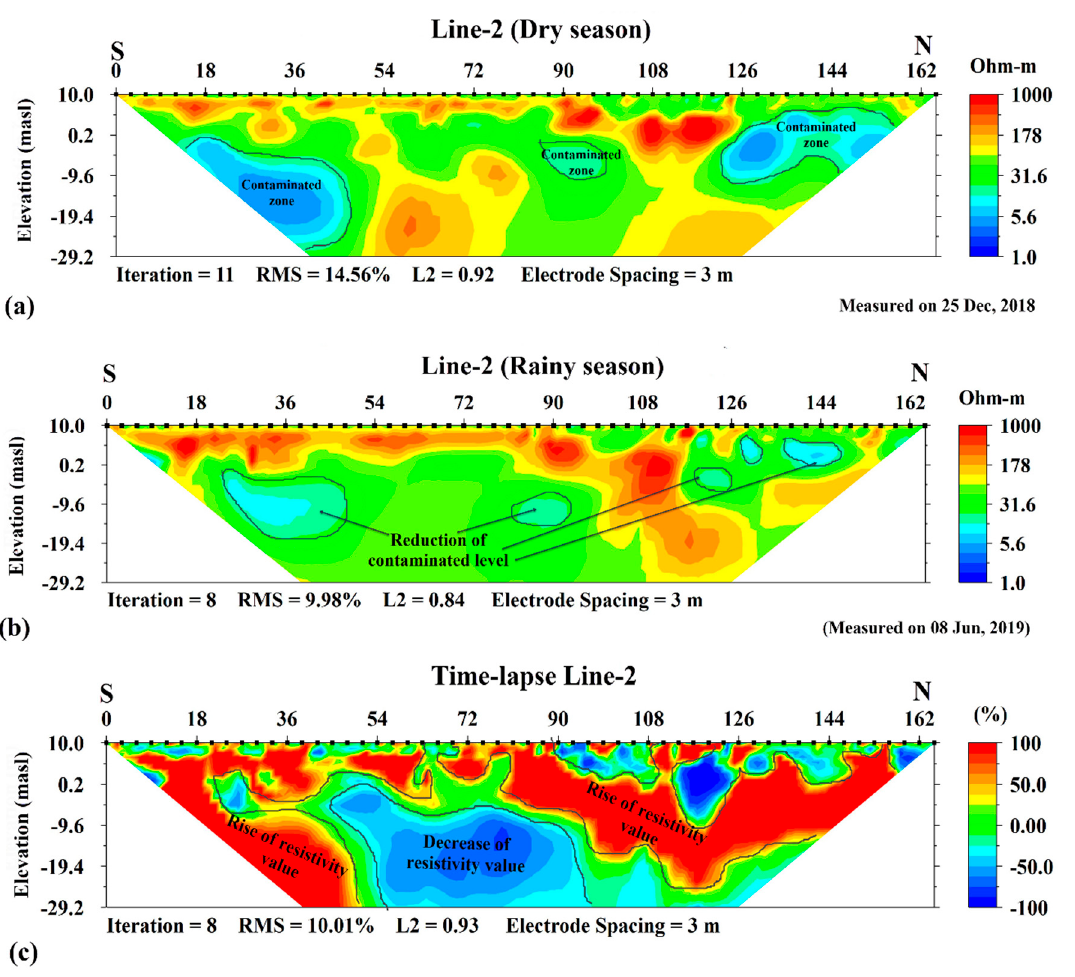
Figure 8. Time-lapse ERI inversion: ( a ) ERI-Line-2 in dry season, ( b ) ERI Line-2 in rainy season, and ( c ) TL-ERI Line-2.